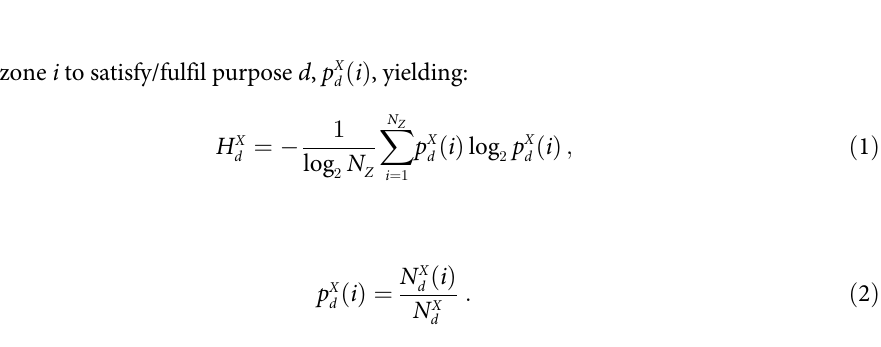
Fig 1. Density map of work travels made in BGT during the year 2019. Brighter colours represent a higher density of travels to work. The hue denotes whether for a given zone the majority of travels were made by women (red), men (green), or by both (yellow). The inset portrays a zoom of the city centre. Figure contains information from OpenStreetMap and OpenStreetMap Foundation, which is made available under the Open Database License.